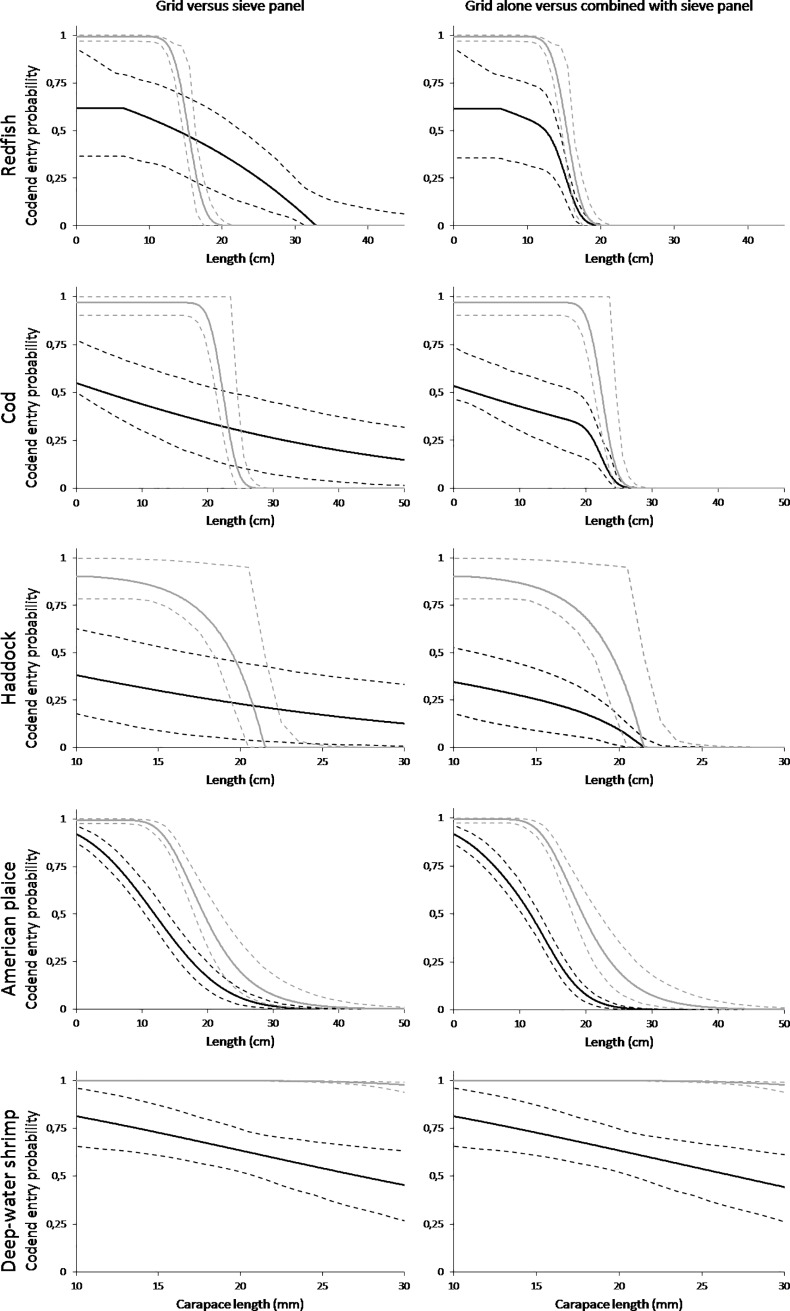
Predicted length-dependent codend entry probabilities.Left column shows the Nordmøre grid standalone deployment (grey curve) versus the sieve panel standalone deployment (black curve). The right column shows the Nordmøre grid standalone deployment (grey curve) versus the Nordmøre grid and combined sieve panel (black curve). Graphs in the top row show data for redfish, followed by cod, haddock, American plaice and deep-water shrimp in the bottom row. Solid curves represent the predicted probabilities. Dashed curves represent 95% confidence bands for the predicted probabilities.